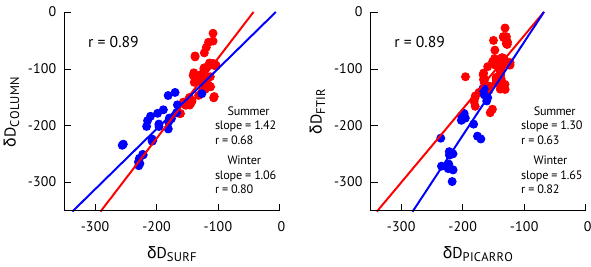
Figure 14. Comparison of columnar δ D v vs. δ D v at surface: ECHAM5-wiso averaged using Eq. (2) δ D v vs. ECHAM5-wiso δ D v at surface (left panel), and FTIR retrievals compared to δ D v measured by Picarro instrument at surface (right